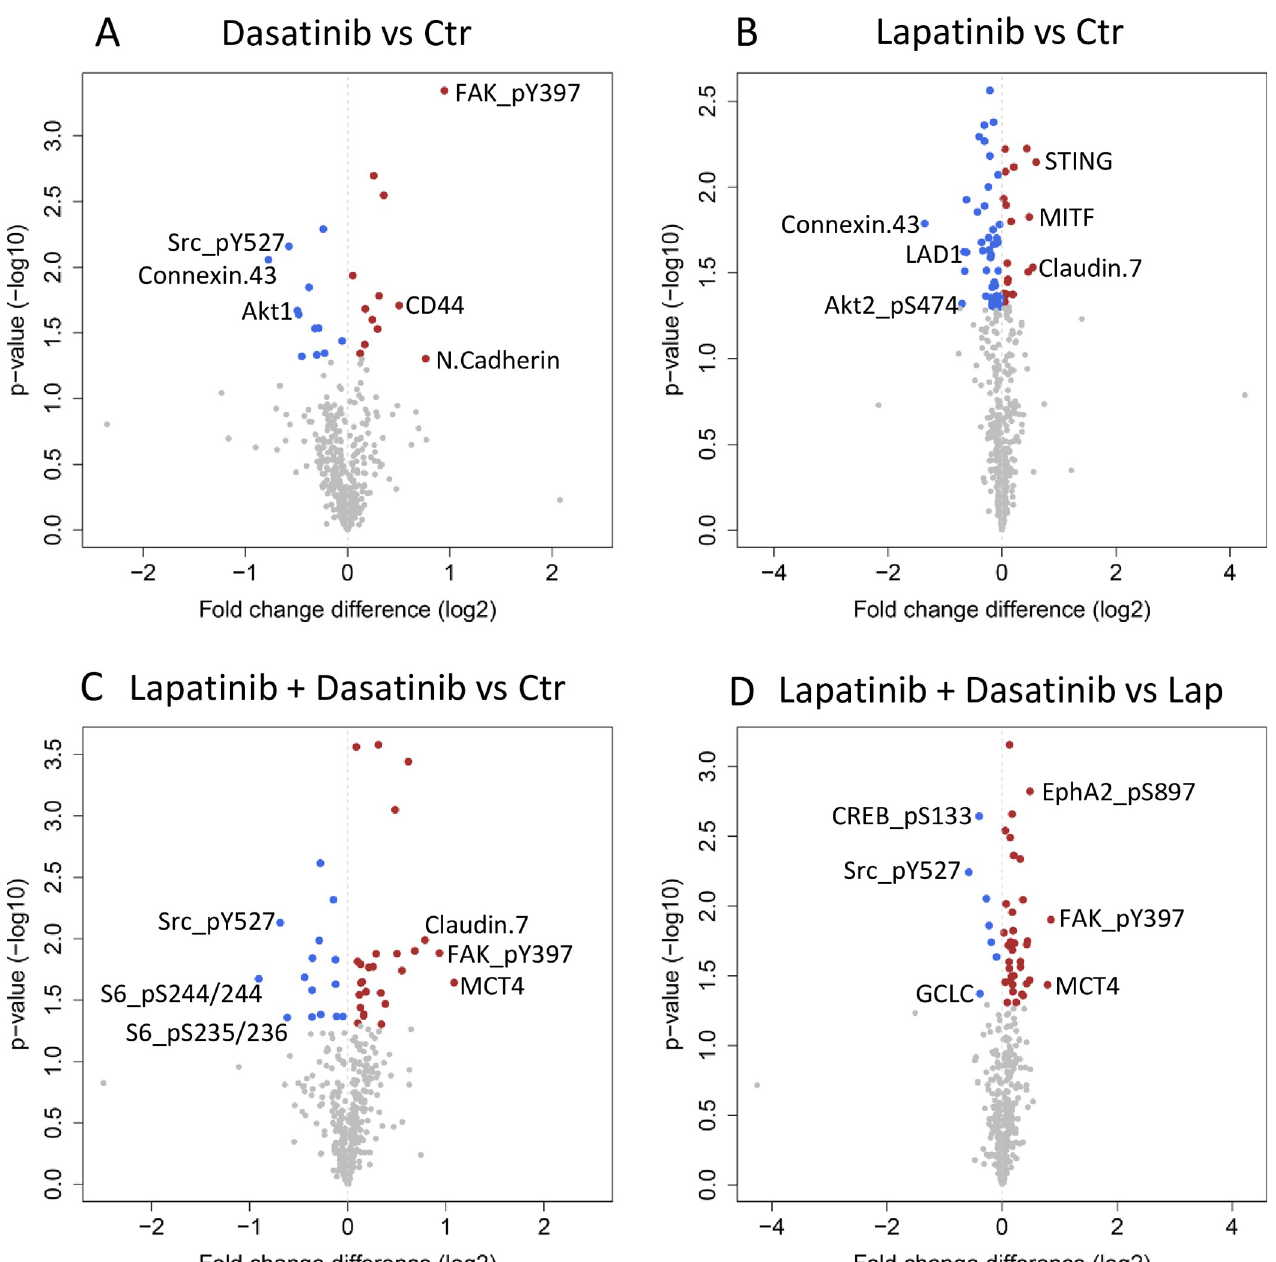
Fig 7. Changes in protein expression levels in tumors treated in vivo . Volcano plots of changes in protein levels in tumors treated with A) dasatinib, B) lapatinib, C) lapatinib + dasatinib vs control, and D) lapatinib + dasatinib vs lapatinib. Colored dots represent proteins significantly ( p < 0.05) upregulated (red) or downregulated (blue), calculated by Student’s t-test. Proteins with the top three largest fold change in downregulation and upregulation are labelled with names. All significant protein changes are listed in Tables 1 and